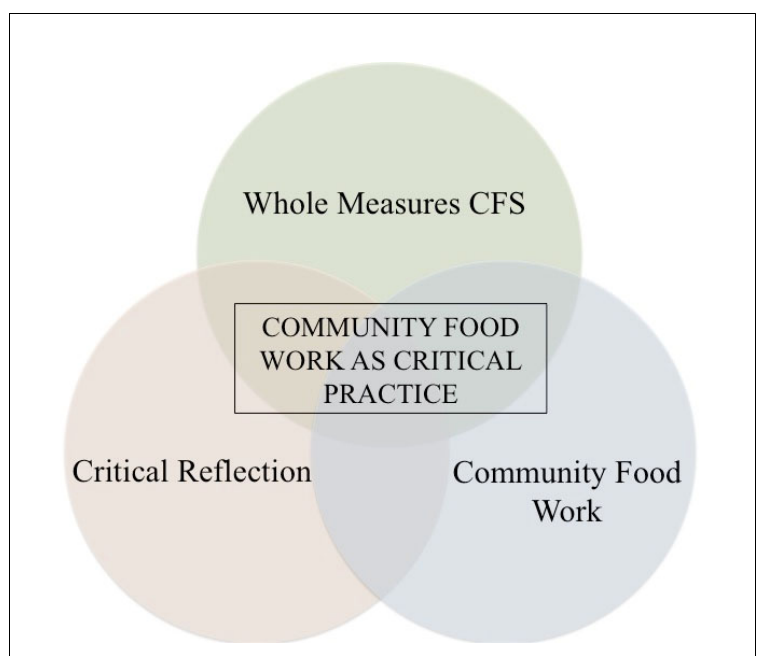
Figure 1. Diagram of the Conceptual Framework Guiding this